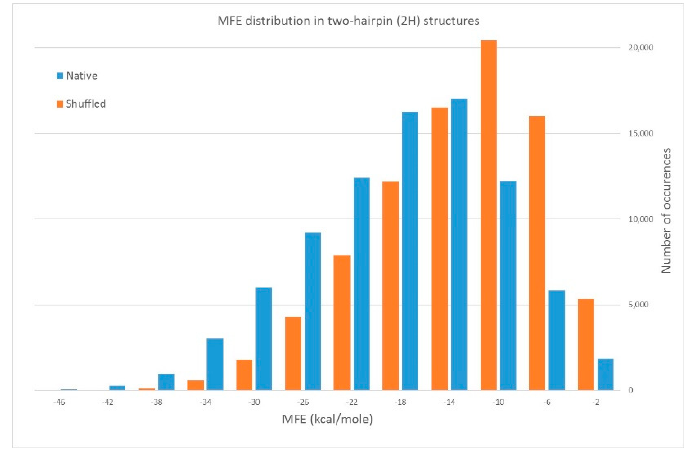
Figure 7. The MFE distribution of all two-hairpin (2H) structures in our dataset comparing native and shuffled sequences. Reported p -value (see text) is less than 0.0001.